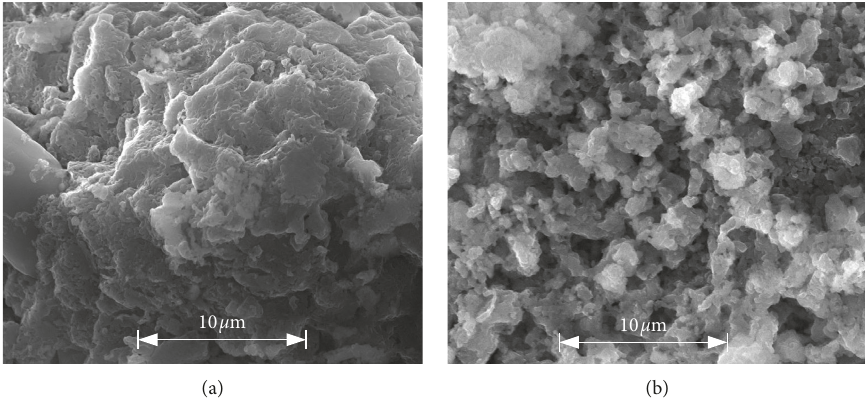
Figure 7: Combustion residue SEM images of (a) HL and (b) BA.